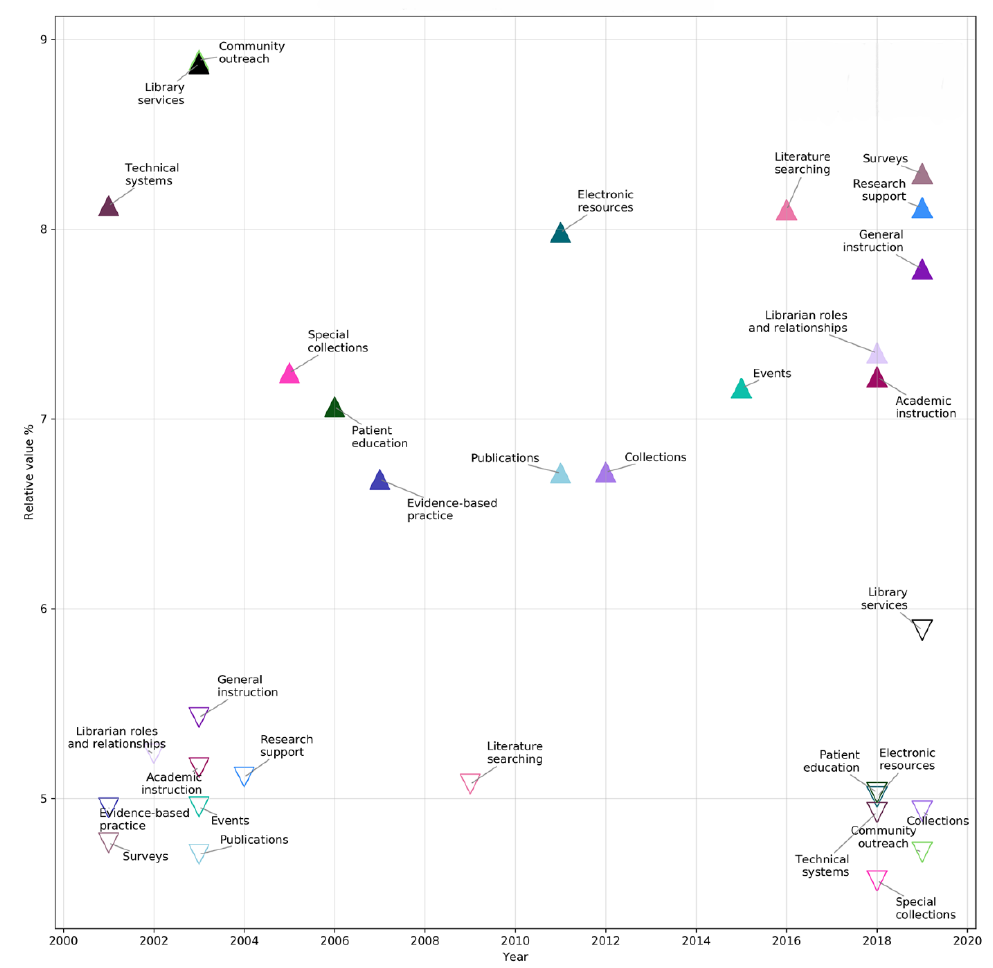
Solid triangles represent the maximum relative result. Open triangles represent the minimum relative